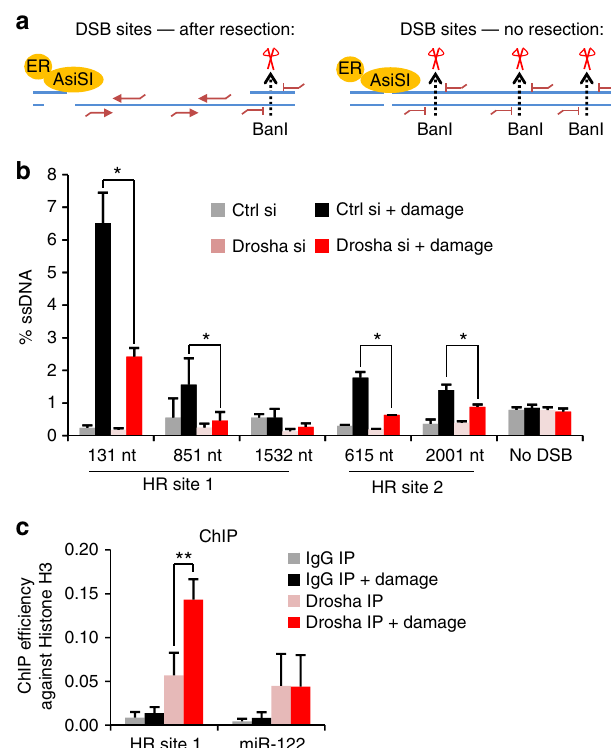
Fig. 5 Drosha is required for DNA resection after DNA damage and is recruited to DSBs. a Cartoon describing quantitative DNA resection assay. Treatment of U2OS cells with 4-OHT induces damage by HA-ER-AsiSI. Genomic DNA is harvested and subjected to restriction digest (dotted lines). qPCR primers, red lines, are designed at either side of the restriction sites. Only loci that had been resected prior to digest can be ampli fi ed. b qPCR resection assay as in a at two HR sites, and the control locus (no DSB) which does not span an AsiSI restriction site, as described in ref. 7 following 4 h of damage induction. Error bars = SD, Student ’ s 2-sample T a canonical Drosha binding site at the miR-122 genomic locus 1 h after damage induction. The ChIP ef fi ciency was calculated against a histone H3 ChIP performed in parallel, error bars = SEM, Student ’ s 2-sample T